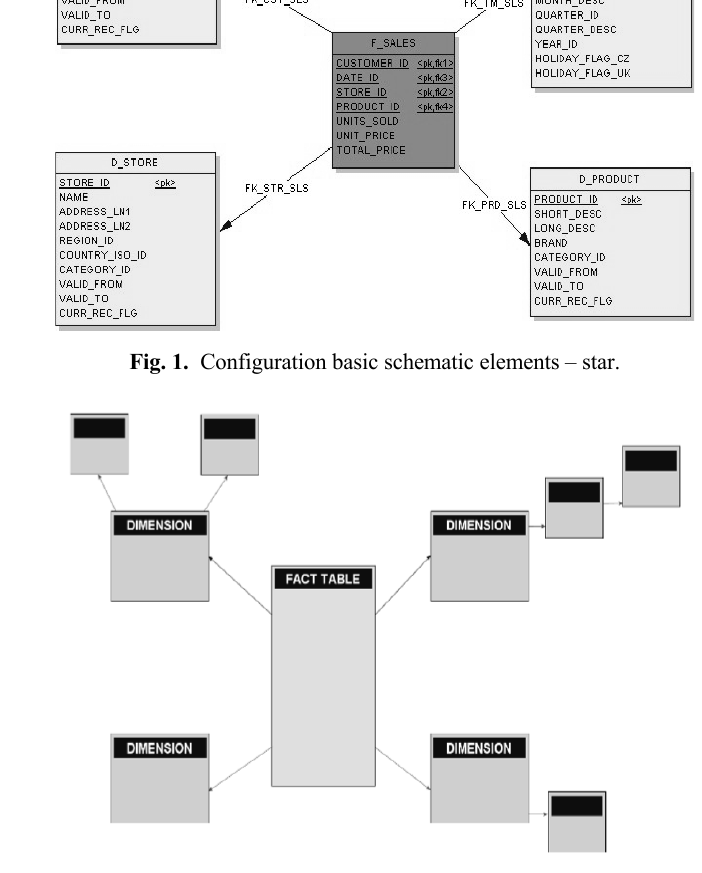
Fig. 2. Configuration basic schematic elements –